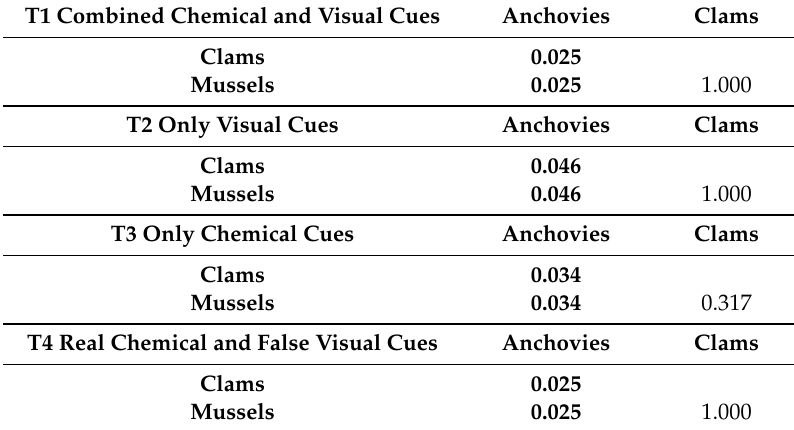
Table 7. Maintained food preference during problem-solving tasks in Octopus vulgaris . Wilcoxon matched-pairs test significance p -value.